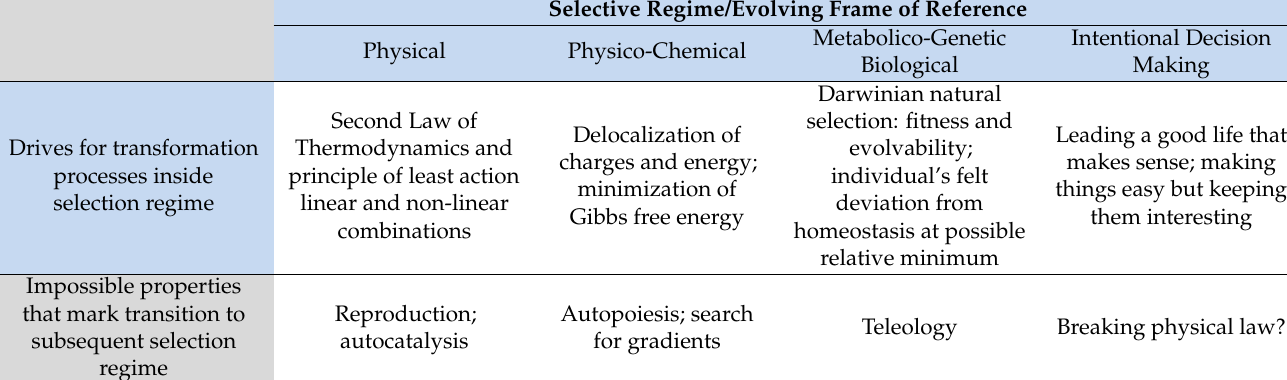
Table 1. Selection regimes in the course of evolution of information processing systems on